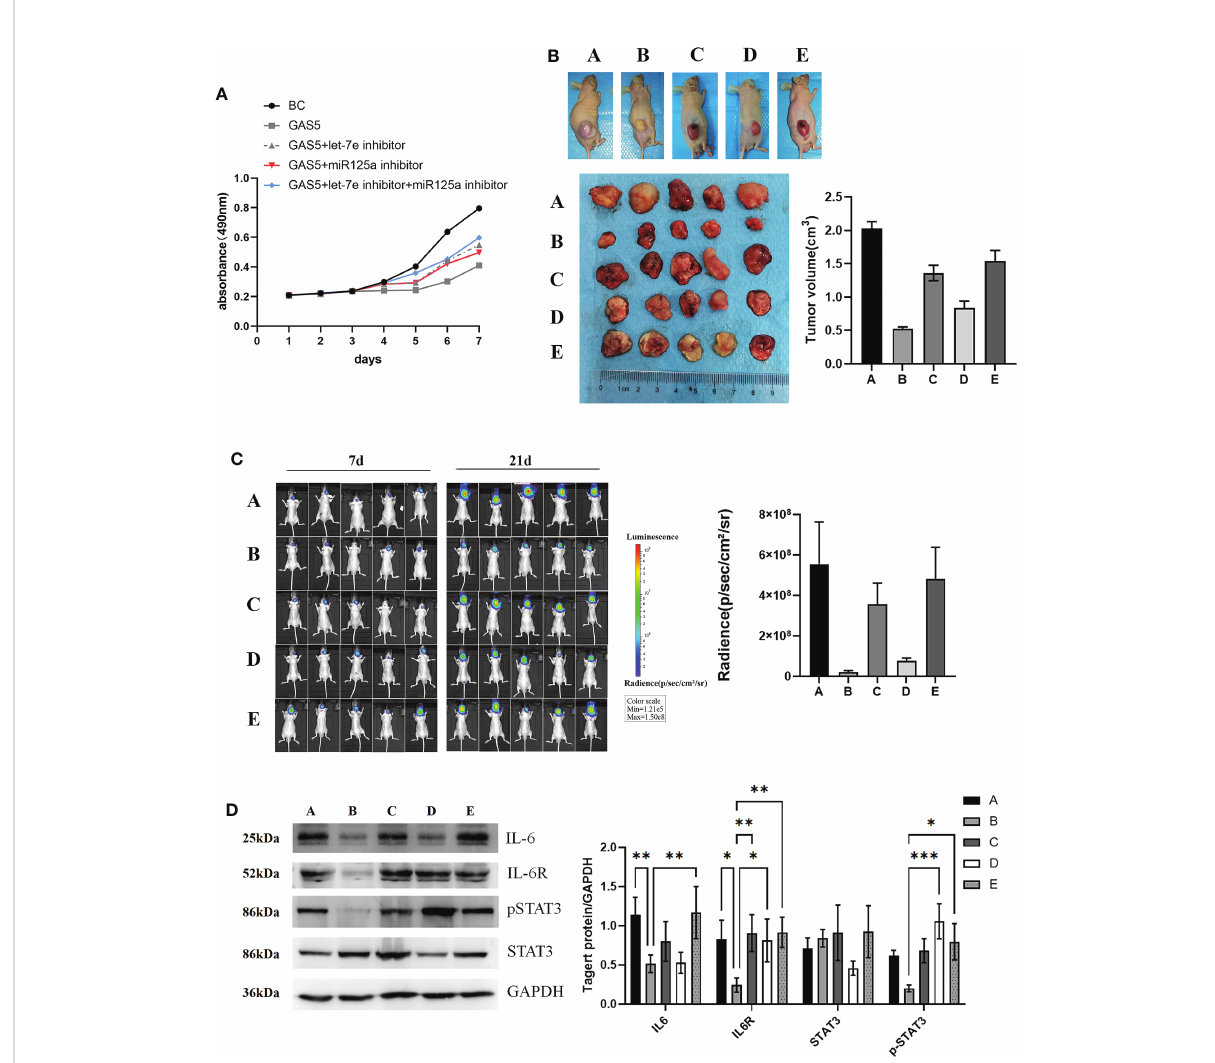
FIGURE 6 LncRNA-GAS5 plays the role of antioncogene in GBM with the involvement of let-7e and miR-125a. (A) Supernatant rescue assay showed the results of CCK-8 assay analysis of the effect of let-7e inhibitor/miR-125a inhibitor transfected on the GAS5 overexpression U87 cells (n=3). (B) U87 cells are transfected with GAS5 overexpression lentivirus, miR-125a inhibitor and let-7e inhibitor individually or jointly and they are injected subcutaneously (5×10 6 cells) into the nude mice (n=5/group). Five images of the subcutaneous tumor of nude mice and the tumor volume are shwon (tumor volume=0.5×l×l×w, l=tumor length, w=tumor width). (a: Control, b: GAS5 overexpression, c: GAS5 overexpression+let-7e inhibitor, d: GAS5 overexpression+miR125a inhibitor, e: GAS5 overexpression+let-7e inhibitor+miR125a inhibitor) (C) U87 cells are transfected with GAS5 overexpression lentivirus, miR-125a inhibitor and let-7e inhibitor individually or jointly and they are injected stereotactically into the brain (5×10 6 cells) into the nude mice (n=5/group). The bioluminescence imaging assay is used to detect the excitation fl uorescence in the brain tumor of the nude mice and the relative photons fl ux is estimated. (a: Control, b: GAS5 overexpression, c: GAS5 overexpression+let-7e inhibitor, d: GAS5 overexpression+miR125a inhibitor, e: GAS5 overexpression+let-7e inhibitor+miR125a inhibitor) (D) Proteins are extracted from the nude mice tumors tissues that we formed subcutaneously before. IL-6, IL-6R, STAT3, pSTAT3 are determined by western blot analysis (n=3). Quantitative results of western blot analysis are shown. Data are presented as the mean ± S.D. P value is determined by Student ’ s t test (*P < 0.05, **P < 0.01, ***P <